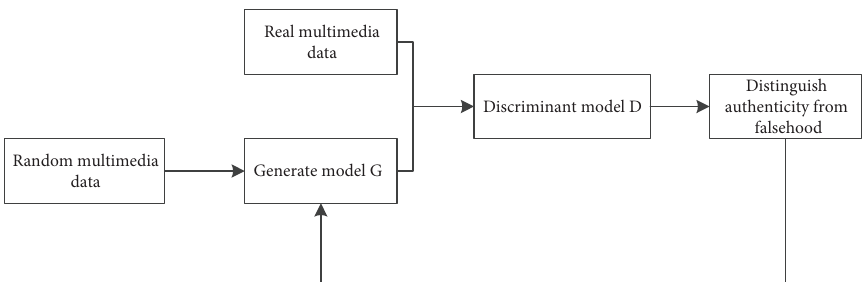
Figure 5: Deep learning GAN network model